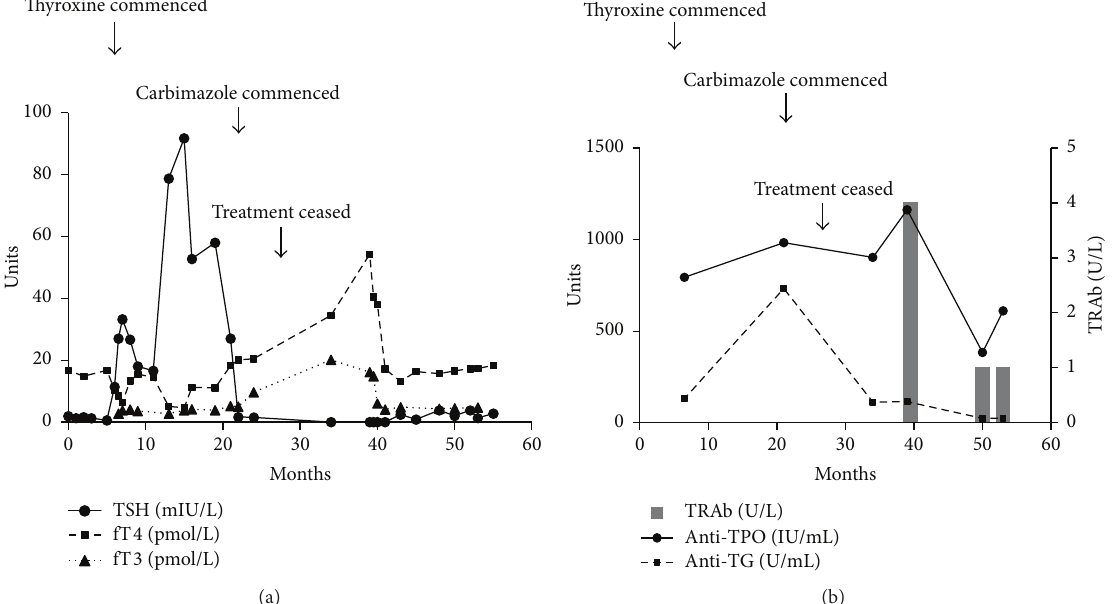
Figure 1: (a) Temporal pattern of thyroid function tests showing both hypothyroidism and subsequent T3-toxicosis, consistent with Graves’ Disease. (b) Thyroid antibodies showing persistently elevated anti-TPO and later development of thyrotoxicosis with positive TRAb titres. TSH, thyroid stimulating hormone ; fT4, free thyroxine ; fT3, free triiodothyronine ; anti-TPO, anti-thyroperoxidase antibody ; anti-TG, anti- thyroglobulin antibody ; TRAb, TSH receptor antibody .